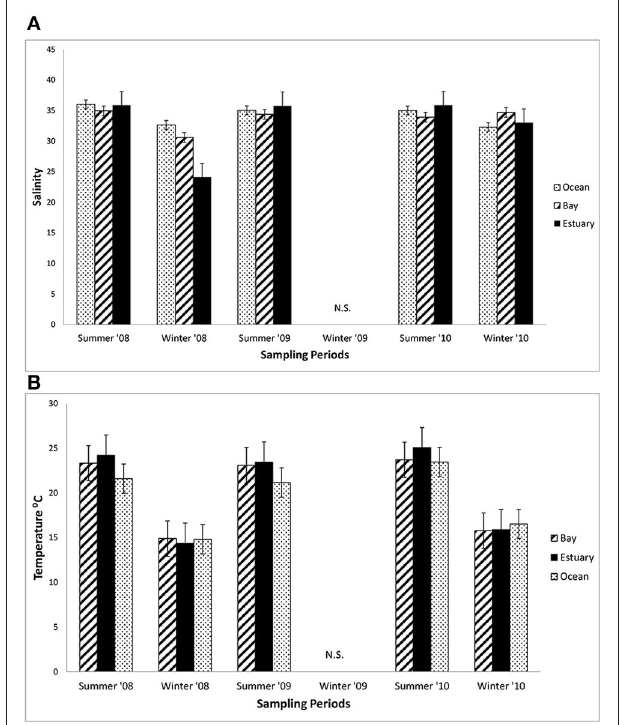
FIGURE 3 | Mean salinity and water temperature. (A) The mean salinity ( ± 1 SE each season) at sampling sites in the Ocean, Bay, and Estuary ( N = 9 for Ocean means, N = 24 for Bay and Estuary means). N.S. = Not Sampled. (B) The mean daytime water surface temperature ( ± 1 SE each season) at sampling sites in the Ocean, Bay, and Estuary. ( N = 9 for Ocean means, N = 18 for Bay and Estuary